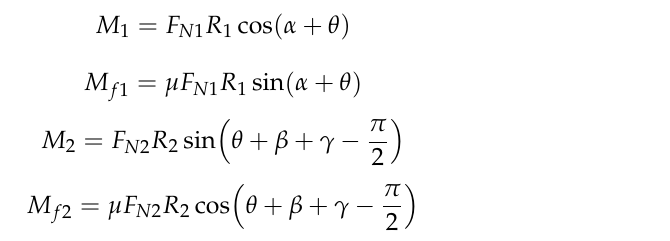
Figure 6. Three-dimensional design diagram of trigger mechanism installed in corer.